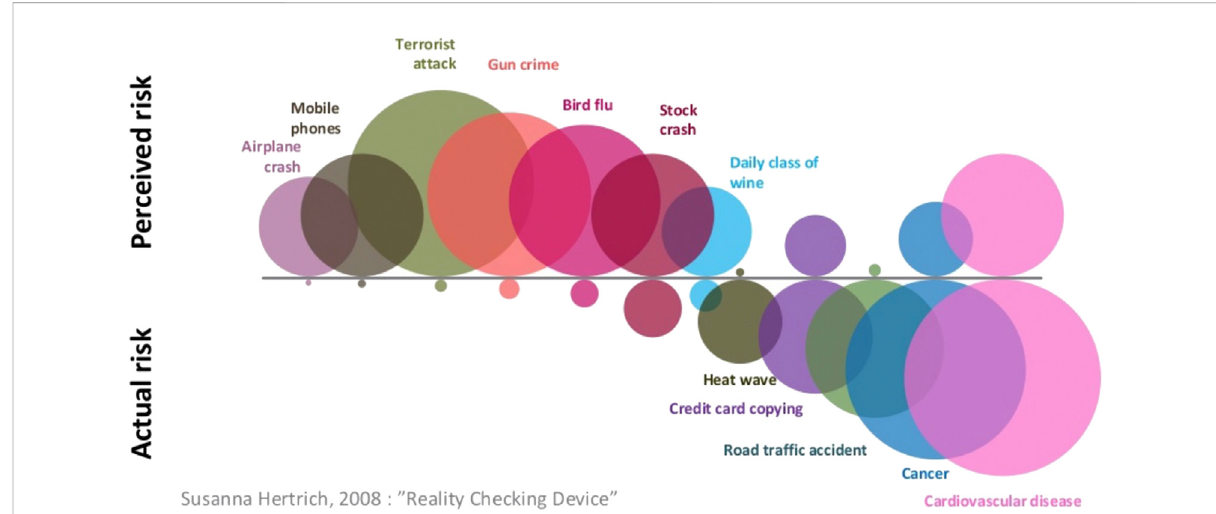
Comparison among different estimated vs. perceived risks. The circles ’ size below and above the horizontal axis are proportional to the “ real ” risk (estimated on a statistical basis) and the perceived one (estimated from perception studies), respectively. Modi fi ed from: Risk perception and actual risk . Image by Susanna Hertrich (2008) (based on the work of Dr Peter M.